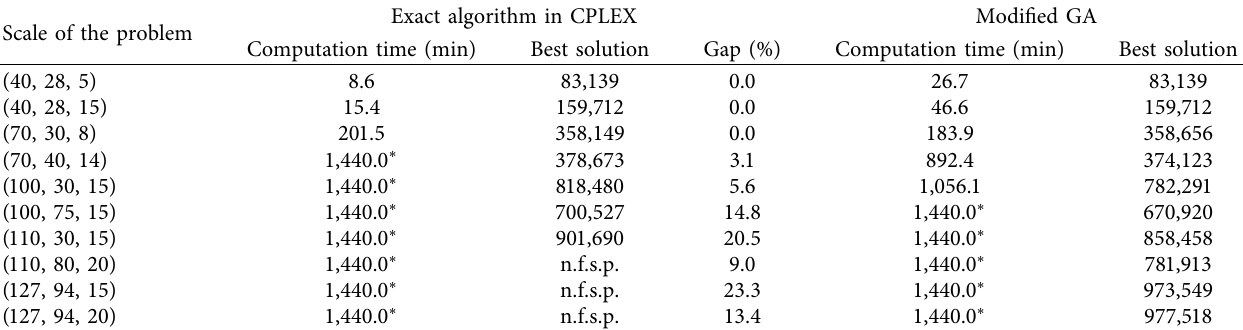
Table 3: Comparison of results and computation times of the